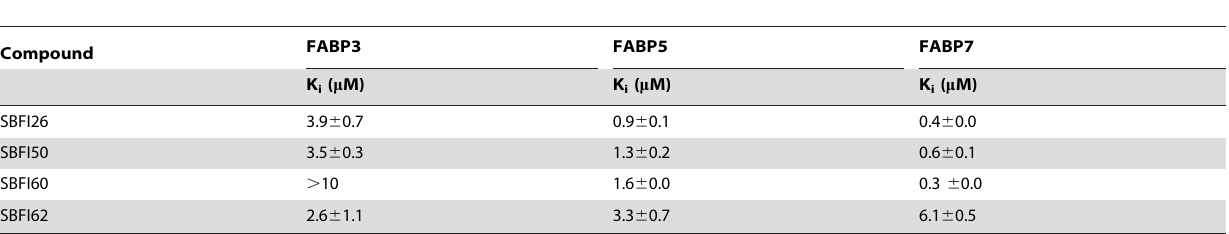
The K i values represent averages 6 S.E. of three independent experiments. doi:10.1371/journal.pone.0094200.t002 PLOS ONE |